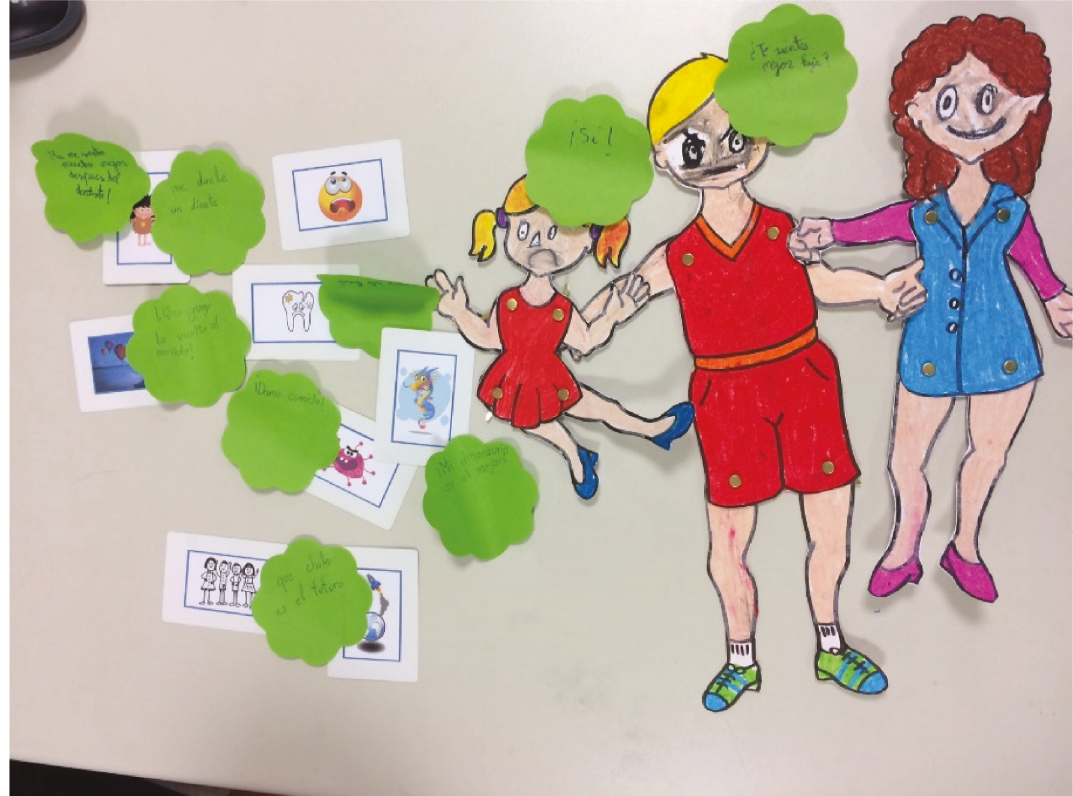
Figure 15: Characters and dialogs (sticky notes) created for the children’s storyboards in the first intervention (summer